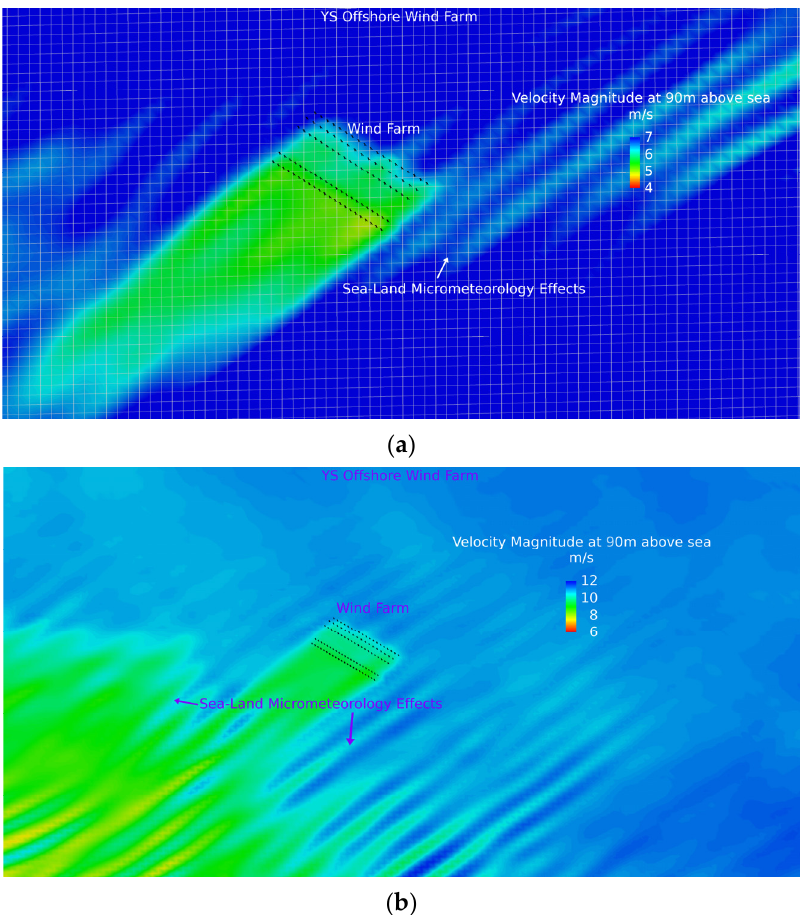
Figure 10. The diagram of wind speed around the wind farm at 16 h and 40 h: ( a ) the spatial distribution of wind speed on the hub height at 16 h under Case III; ( b ) the spatial distribution of wind speed on the hub height at 40 h under Case III.